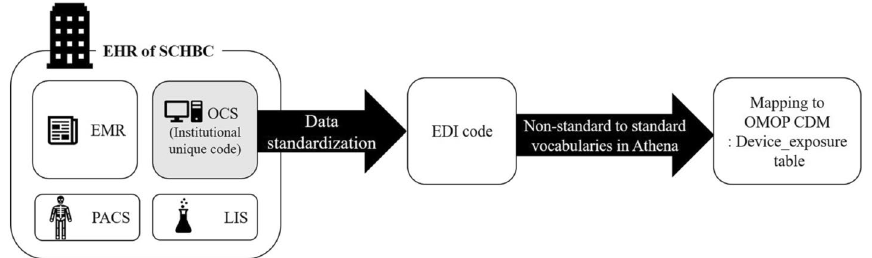
Figure 1. Current CDM mapping process of medical device data in Korea and scopes of this study. Among medical device data recorded in each medical institution’s EHR, the institutional unique code recorded in